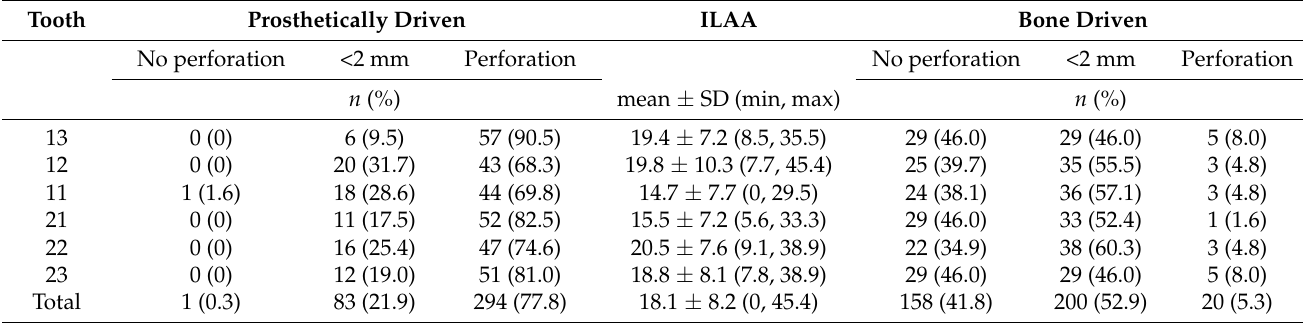
Table 6. Frequency of cortical bone perforation for 3.3/4.3 mm implants, for both prosthetically- and bone-driven positions, and the ILAA. Tooth Prosthetically Driven